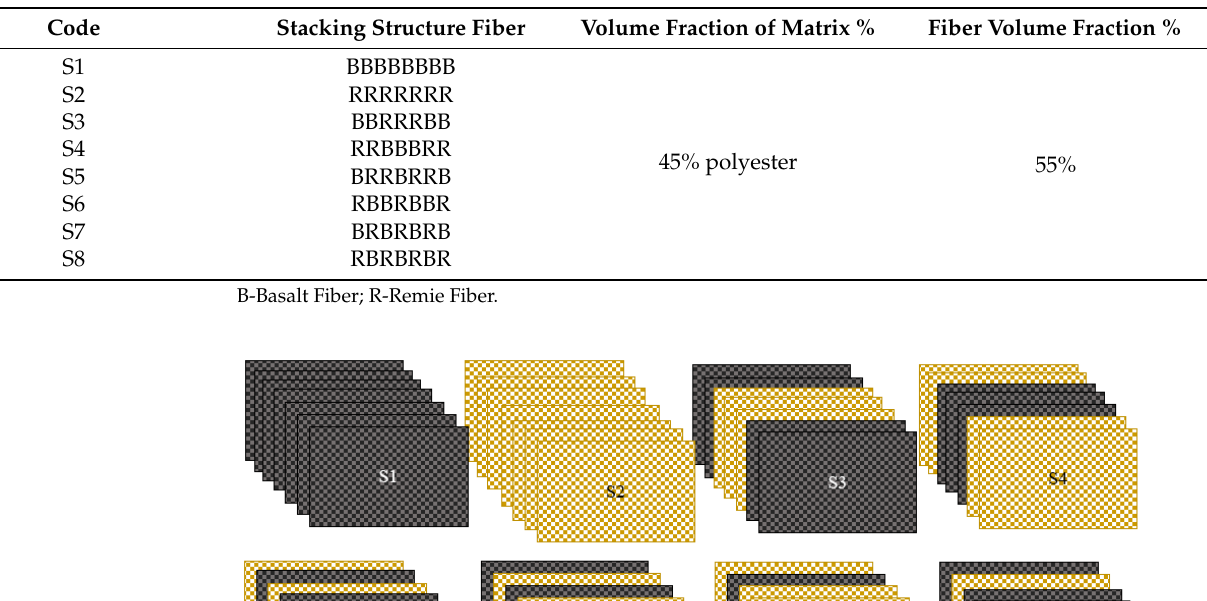
Table 2. Compositions of specimens neatly arranged.